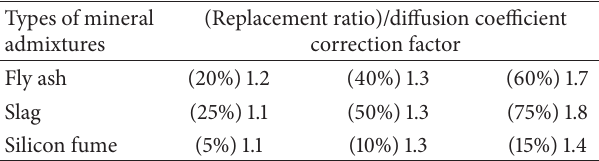
Table 2: Diffusion coefficient correction